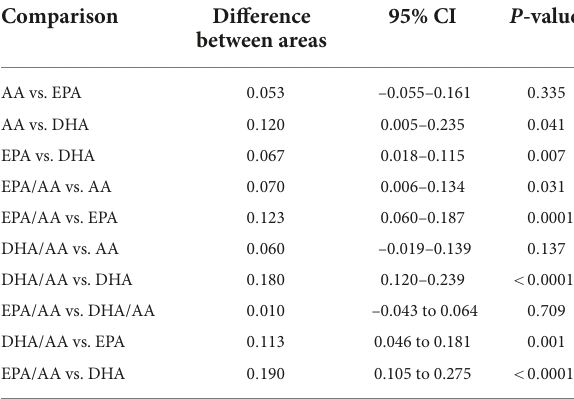
TABLE 5 Pairwise comparisons of ROC